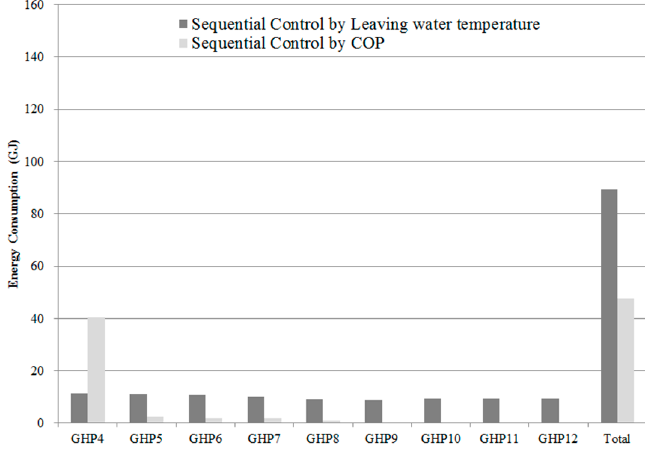
Figure 7. Comparison of the energy consumption at GHPs.